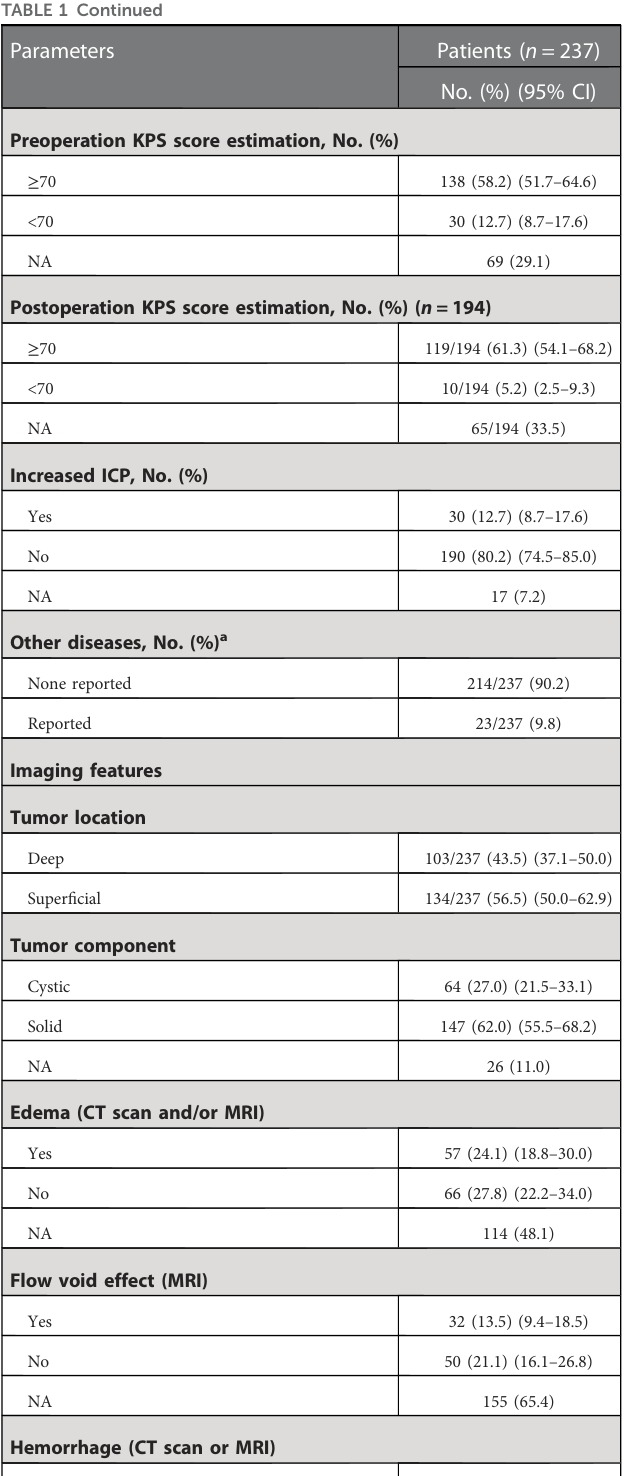
differential analysis of hemangioblastoma at each site showed that tumor size located in the sellar region and the optic nerve were generally smaller, which reached statistical signi fi cance compared with those located in the cerebrum ( Supplementary Figure S1B ). A correlation analysis was performed between tumor anatomical regions and symptoms. We found that patients with sellar lesions V = 0.33), and the optic nerve was strongly correlated with visual defect (Cramer ’ s V = 0.53) ( Supplementary Figure S1C